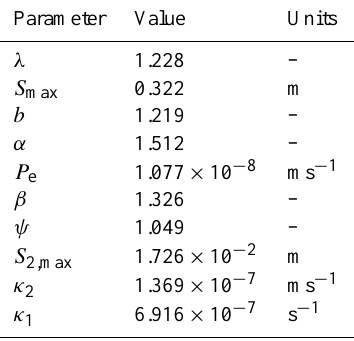
Table 2. Parameter values used by the hydrologic